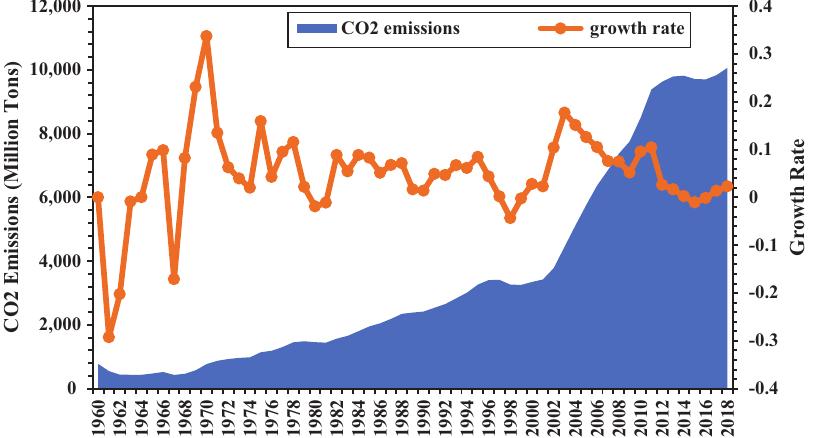
Figure 1. CO 2 emissions